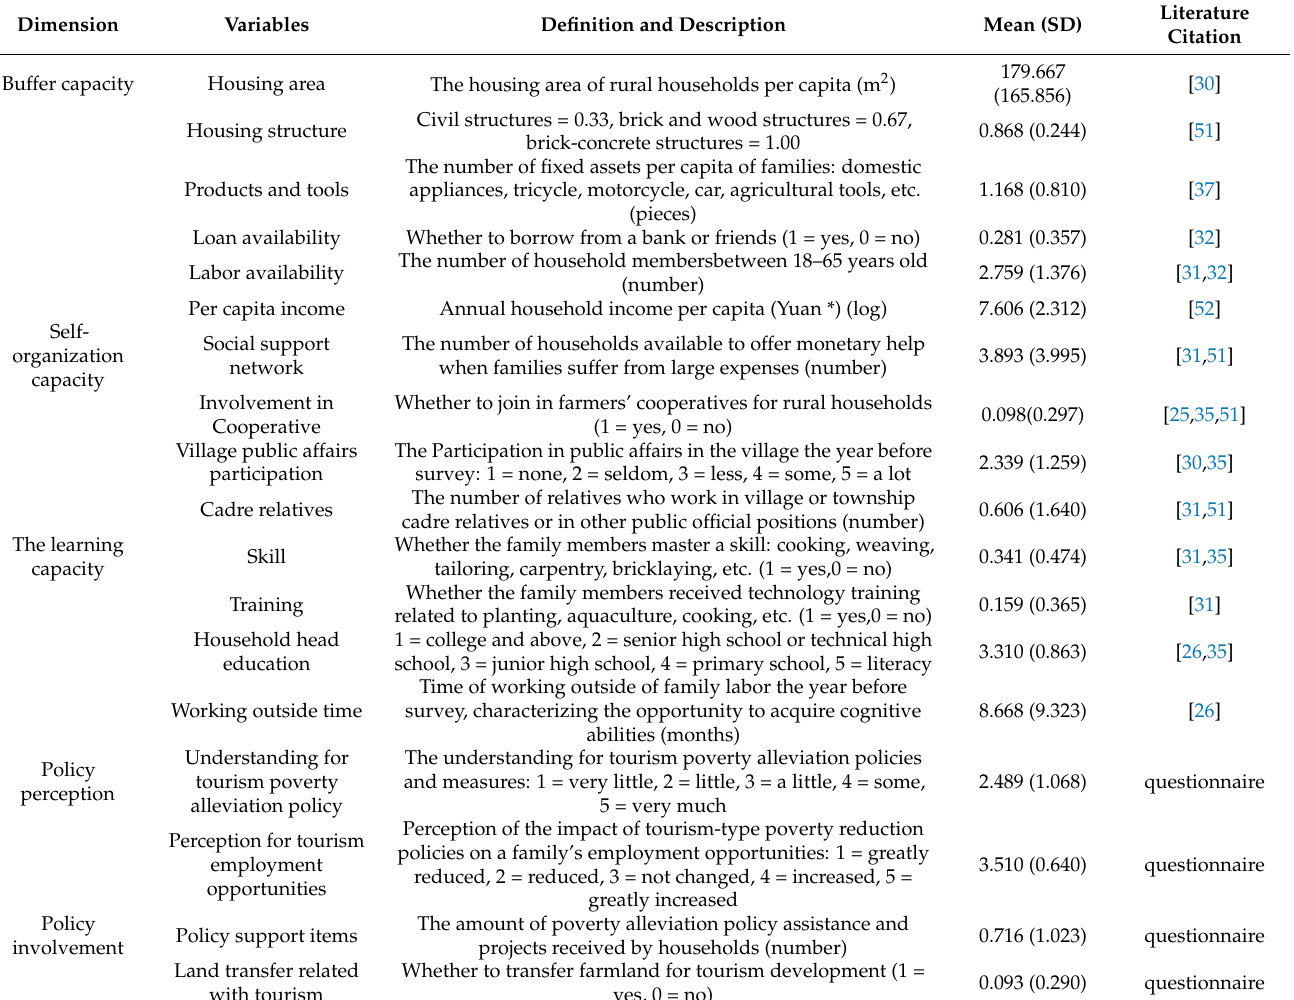
Table 2. Indicators of livelihood resilience, poverty alleviation, policy perception and involvement for rural